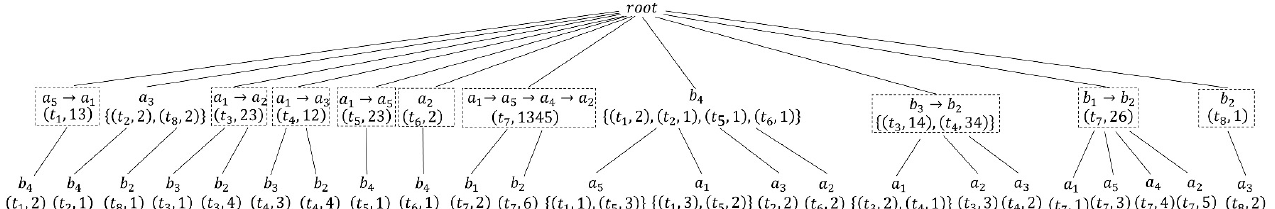
Figure 3. Problematic nodes in Table 1. Problematic nodes are marked with dotted boxes.